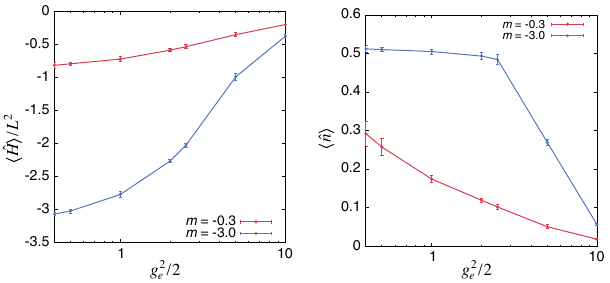
FIG. 11. Numerical results for the ground-state energy ˆ H density h i =L 2 and the particle density h ˆ n i of the original QED Hamiltonian formulation as a function of the electric coupling g for 8 × 8 systems. The lattice spacing is set to a ¼ 1 =t ¼ 1 , and the magnetic coupling is tuned with respect to g 2 mass coupling has been set to m 0 ¼f − 0 . 3 ; − 3 . 0 g , respectively. The data have been obtained by extrapolating from TTN simu- lations with different auxiliary